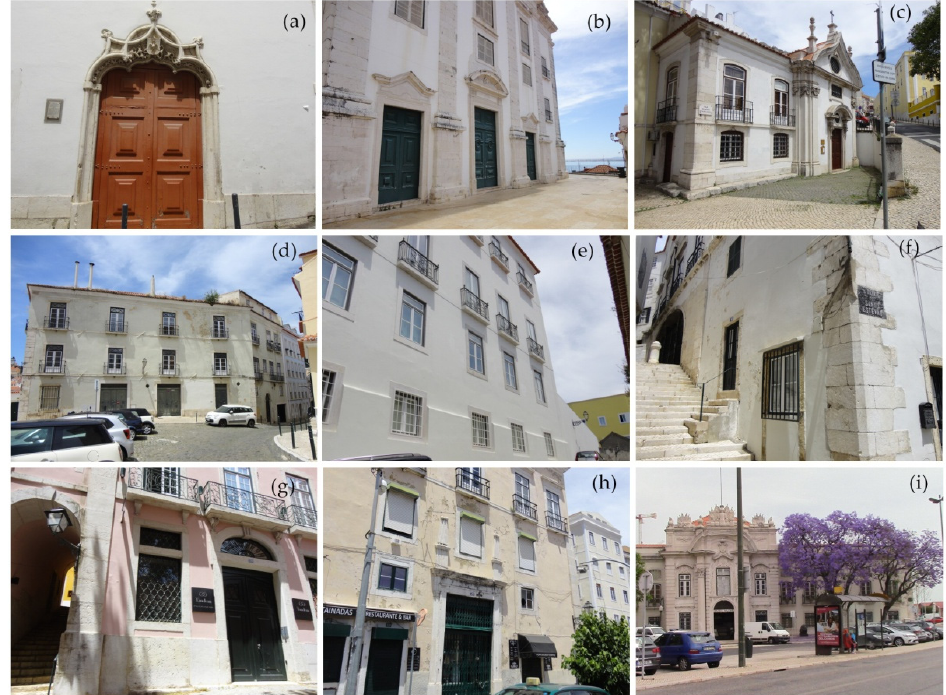
Figure 6. Buildings that still exist today, with locations indicated on Figures 4 and 5. ( a ) 17. Hermitage of Our Lady of Remédios; ( b ) 18. Church of Santo Estevão; ( c ) 19. Hermitage of Jesus da Boa Nova; ( d ) P. Palace Albergaria Freire; ( e ) Q. Palace of Sequeira or Palace of Condes de São Martinho; ( f ) R. Palace of Azevedo Coutinho; ( g ) U. Palace of Dona Rosa; ( h ) W. Palace of Teles de Melo; ( i ) Y. downer iron foundry (today is the Militar Museum).